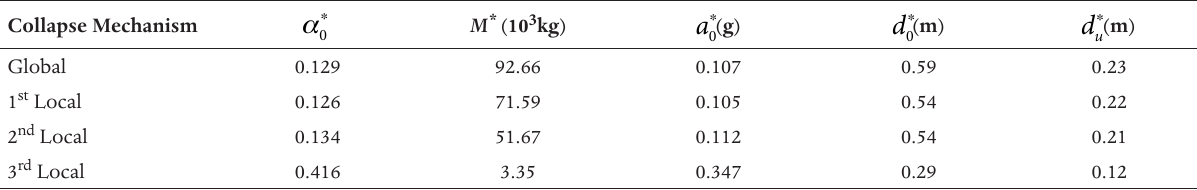
Table 7. Parameters adopted in the limit equilibrium analysis. α ( is the load multiplier; M* is the participating mass; is the spectral acceleration; is the spectral displacement; and is the ultimate 0 displacement).